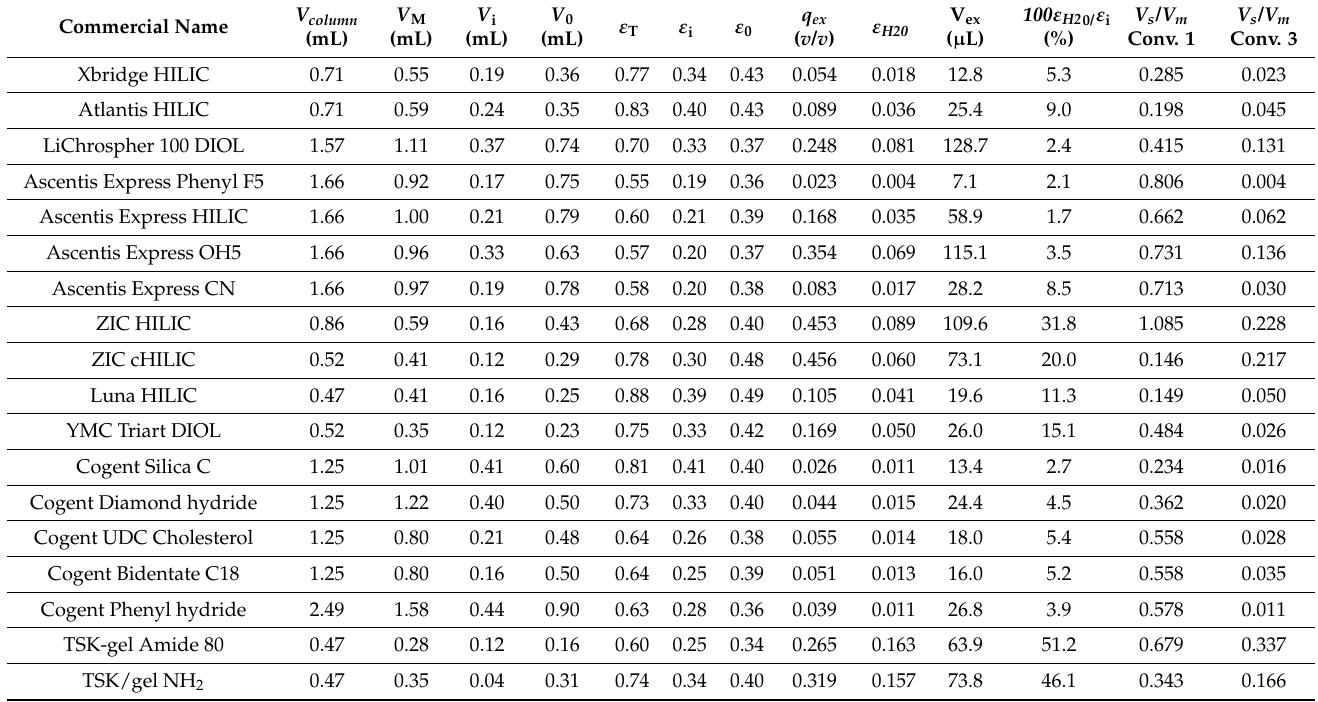
Table 2. Porosities and volumes of the stationary and mobile phases in 18 polar HPLC columns according to different conventions.